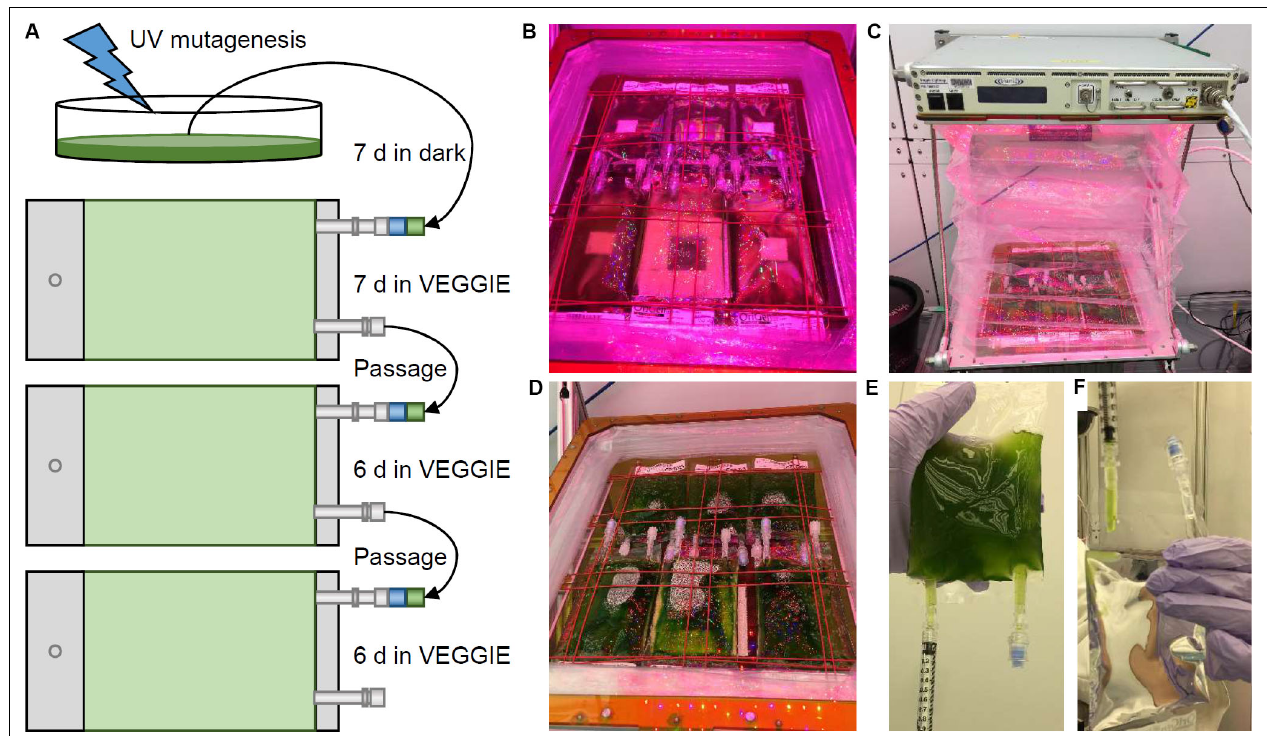
FIGURE 2 | Algae selection experiment in Kennedy Space Center Veggie growth chamber. (A) Schematic of the experiment design and workflow. (B) Initial installation of mutagenized culture bags in the Veggie reservoir. (C) Veggie chamber with algae bags and closed bellows. (D) Algae cultures prior to passage. (E,F) Passage of culture using sterile syringes.